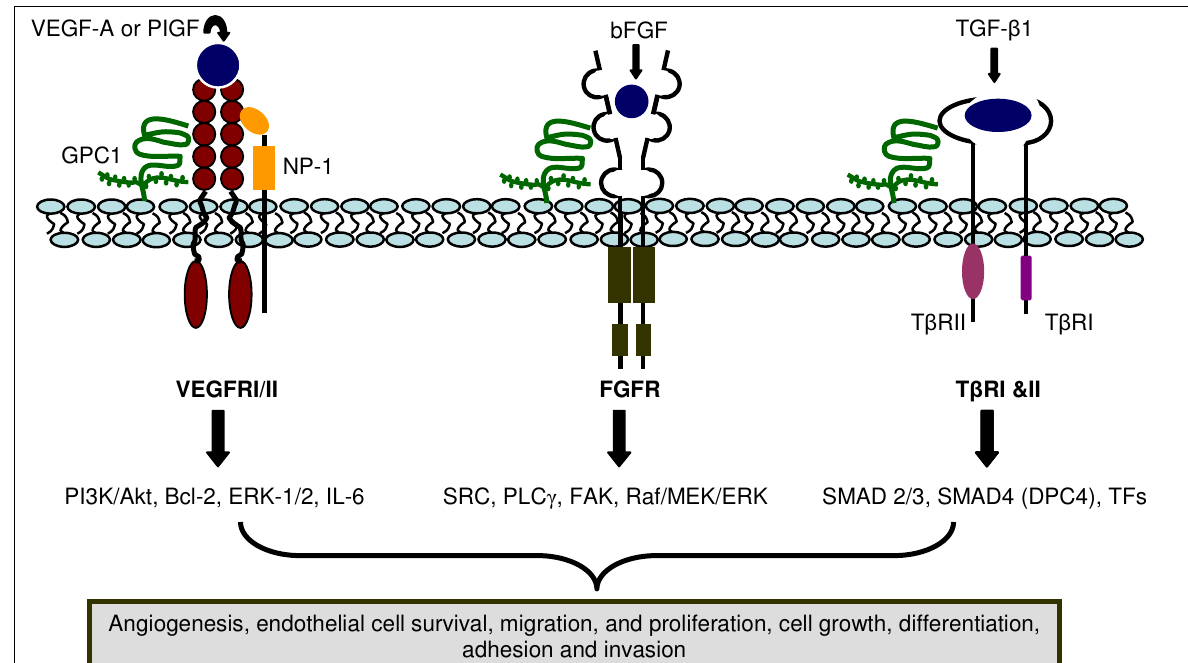
FIGURE 1. Example GPC1 signaling pathways. GPC1 acts as a coreceptor in several important growth signaling pathways, including VEGF, FGF, and TBF- β , all of which have a dramatic impact on angiogenesis and cell adhesion, migration, and